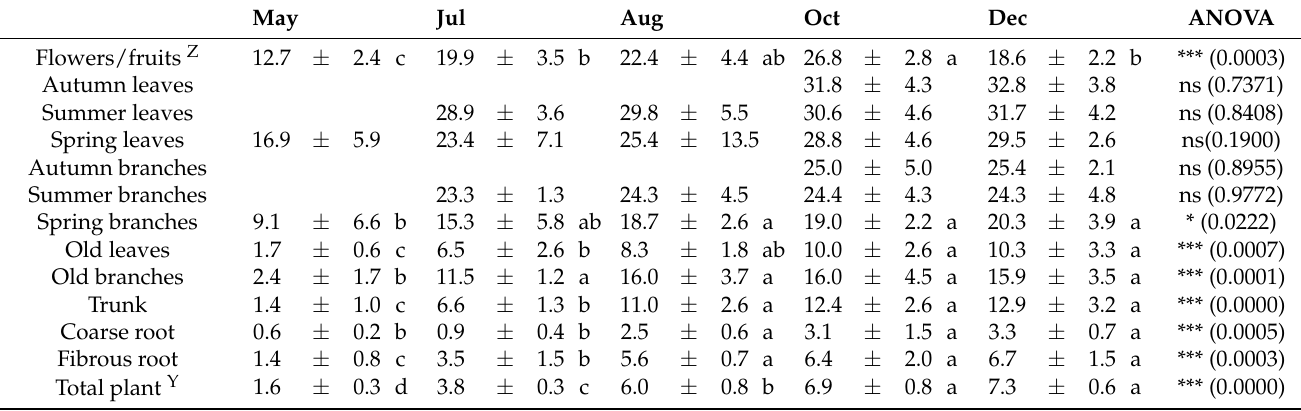
Z Fruits/flowers, in May: flowers, floral button and ovaries; Jul, end of fruit set; Aug and Oct: developing fruits; and, Dec: mature fruits. E 57 Fe (%) organ= 57 Fe (%) organ – 2.20 % 57 Fe (natural abundance in the isotope). 57 Fe PE (%) plant = Σ 57 Fe (mg) organs plant × 100/ Σ